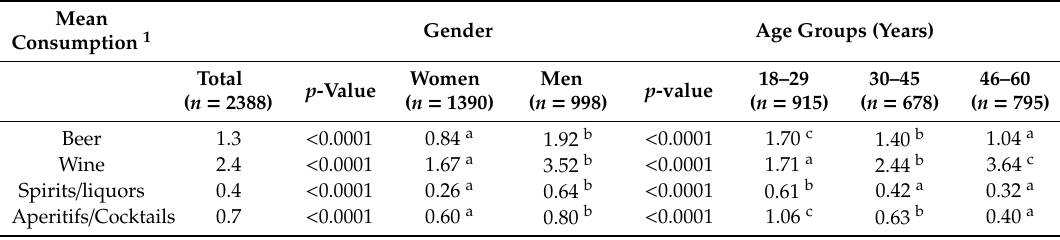
Table 1. E ff ects of gender and age on mean consumption of alcoholic beverages. Di ff erent superscripts indicate significant di ff erences according to Bonferroni post-hoc